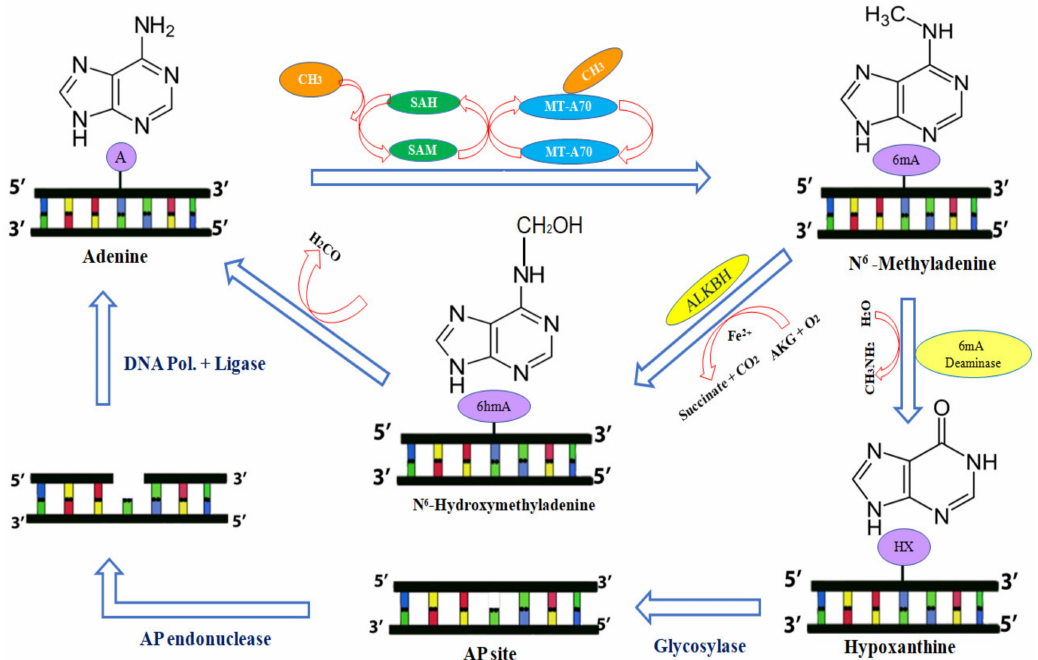
Figure 1. Mechanism of reversible DNA Adenine methylation (6mA)—Using S-adenosyl L-methionine as a methyl group donor, the writer MT-A70 protein family adds methyl group in the 6 th position of purine ring of adenine. It has been shown that 6mA can be converted to unmethylated adenine by the two mechanisms. In the first pathway, 6mA reverts back to adenine by ALKBH family proteins (eraser) by oxidative demethylation via intermediary hydroxymethyladenine (HO-6mA). In yet another mechanism, 6mA is converted back to adenine by 6mA deaminase (eraser) releasing the intermediate product of hypoxanthine, which is recognized and cleaved by glycosylase leaving an apurinic site (AP site). This AP site is further rectified by base excision repair involving AP endonuclease, DNA polymerase and DNA ligase. The 6mA reader proteins, which are e ffi cient enough to recognize methylated adenine motifs, remain